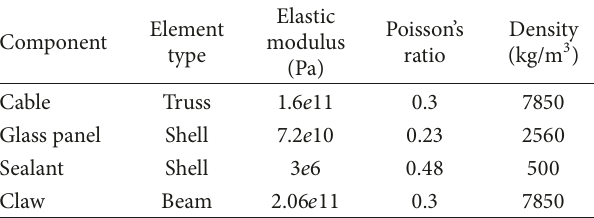
Table 1: Mechanical properties of different